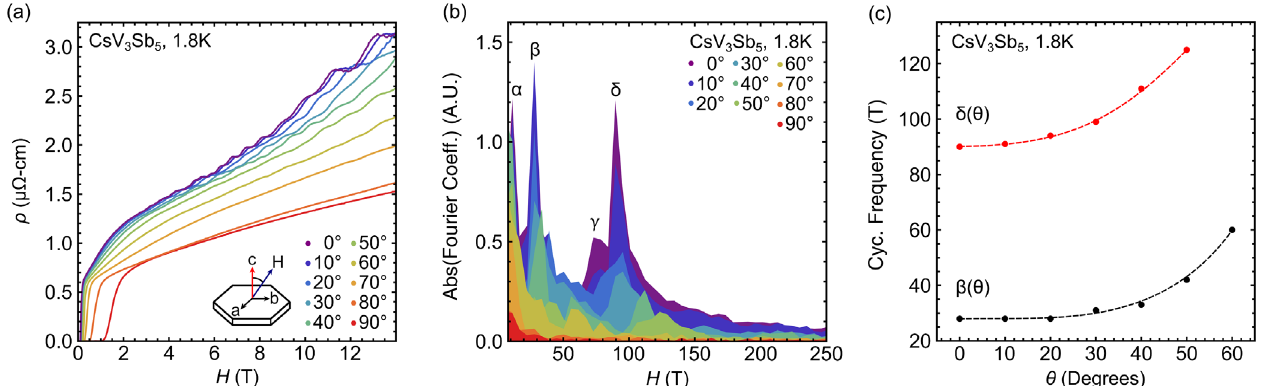
FIG. 6. (a) Raw electronic resistivity as a function of field and angle, where the angle is defined as being between the c axis and the magnetic field. Oscillations are clearly visible at greater than 2 T. The oscillations appear to be dampened with angle, vanishing for θ > 60 °. (b) Fourier transform of angle-resolved SdH data, showing primary low-frequency contributions to the power spectrum. The high-frequency contributions are suppressed rapidly by rotation. (c) Two of the most prominent frequencies ( β , δ ) are shown as a function of rotation angle. Dashed lines serve as a guide to the eye. The frequencies were estimated from (b) using Gaussian functions to approximate both the broadening and shortening of